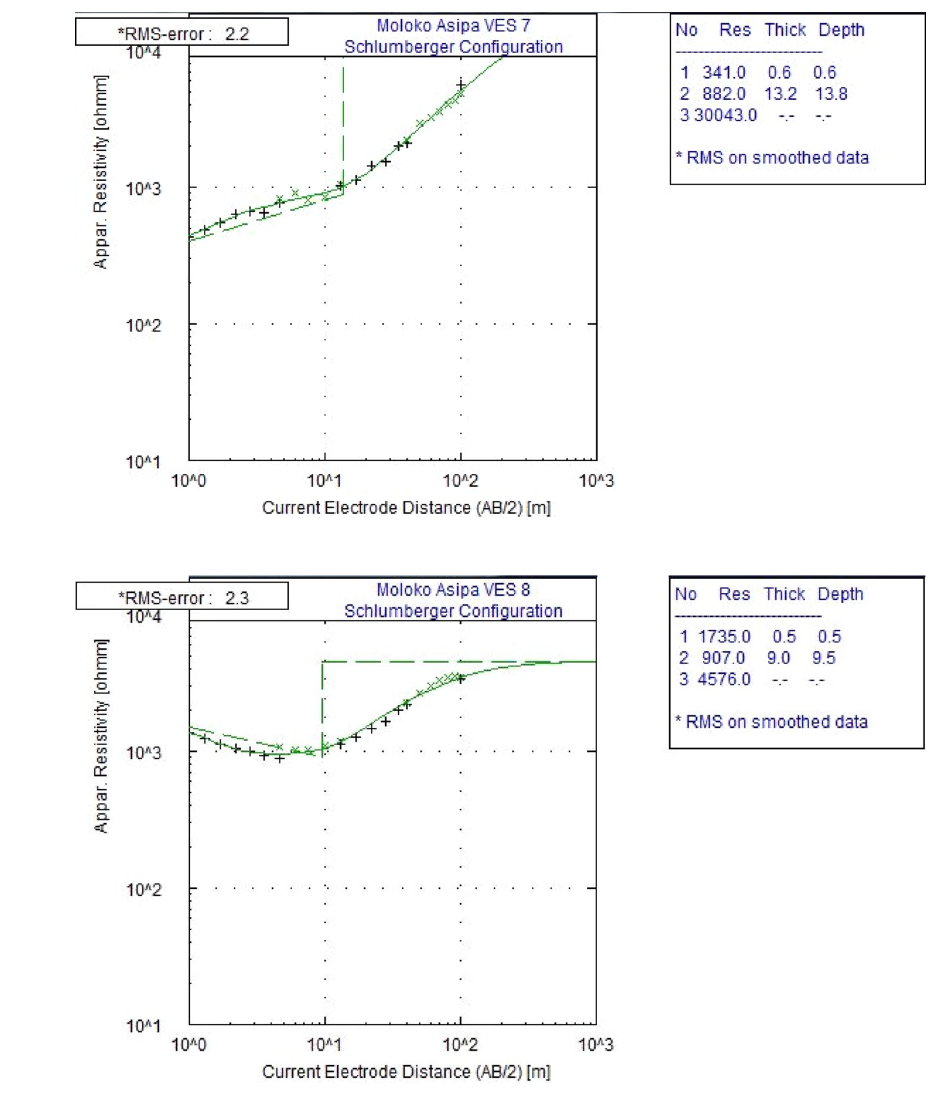
Fig. 16 Layer model interpreta- tion for VES 6